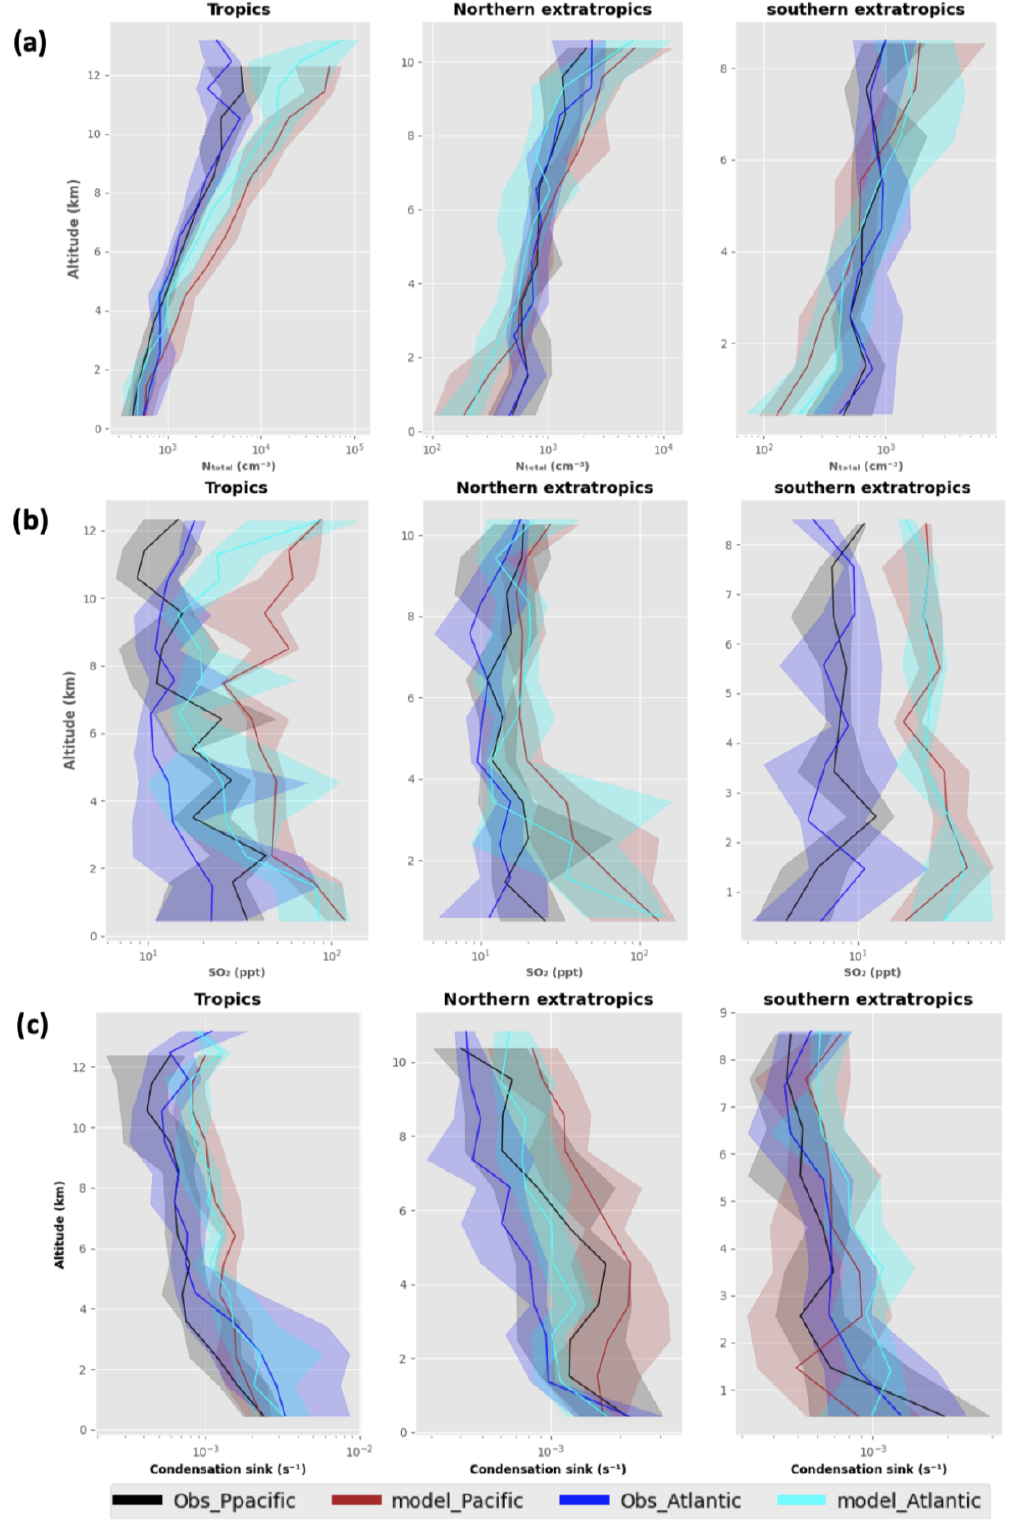
Figure A5. The vertical profiles of the ATom and baseline models (tropics, northern extratropics, 25–90 ◦ N, and southern extratropics, 25–90 ◦ S) in the Pacific and Atlantic oceans: (a) N Total , (b) SO 2 , and (c) condensation sink.